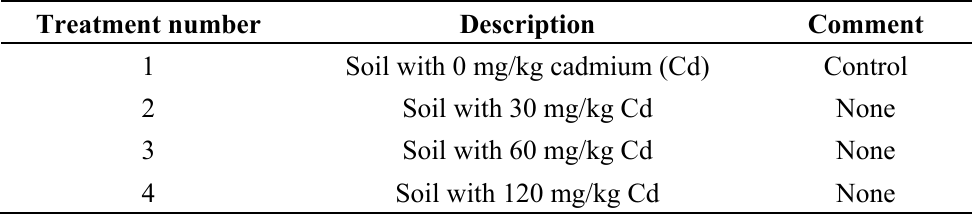
Table 3. Characteristics of the studied treatments.